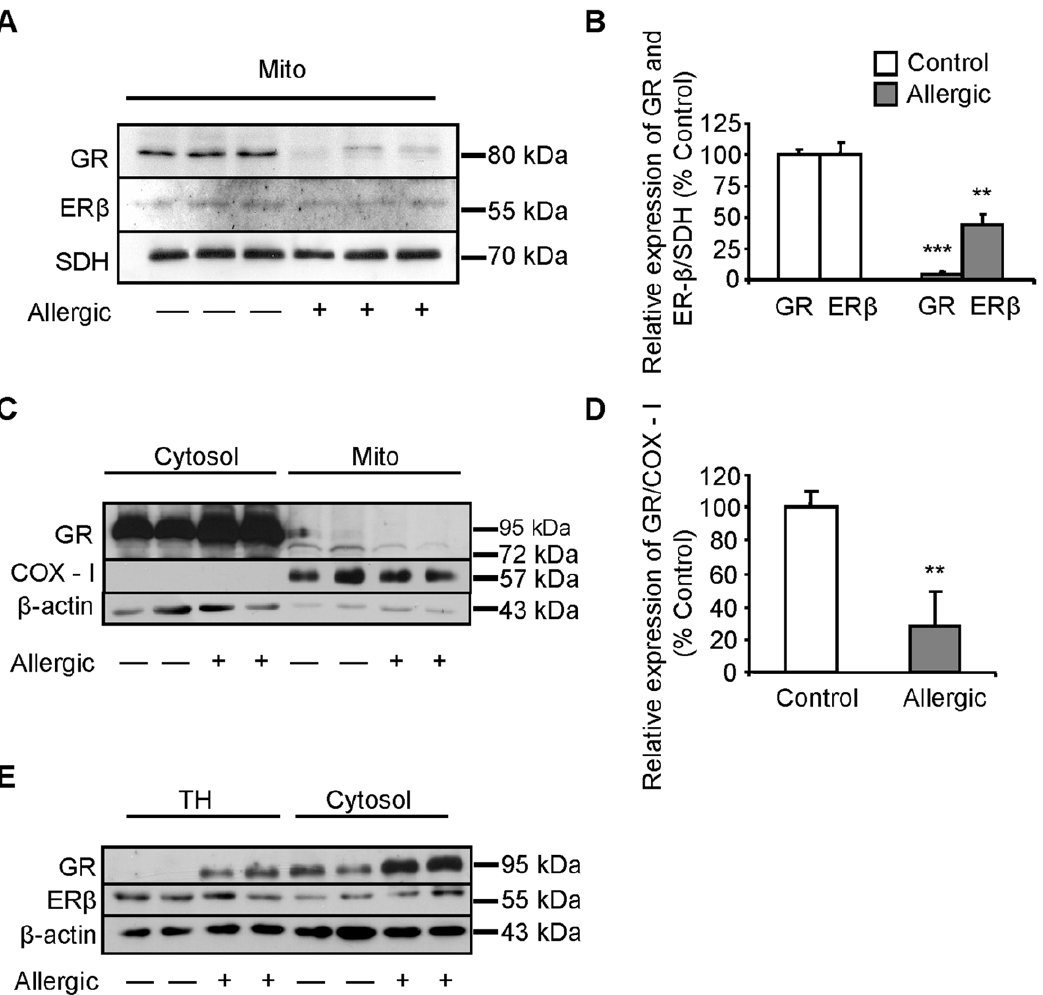
Figure 2. Allergic airway inflammation reduces GR and ER b in highly purified mitochondrial fraction. Highly purified mitochondria were isolated from total lung homogenates from allergic and control mice as described in Methods section. (A) Representative Western blot images showing mtGR and mtER b in isolated mitochondrial fraction. (B) Quantitation of band intensity by densitometry from blots after normalization against the succinate-ubiquinol oxidoreductase subunit of the mitochondrial Complex II OXPHOS enzyme (SDH). (C) Western blot analysis of GR, COX-I, and b -actin protein levels in cytosolic (Cytosol) and mitochondrial (Mito) fractions from control and allergic mice. (D) Quantitation of mtGR band intensity by densitometry after normalization against the expression levels of COX-I protein. (E) Western blot analysis of GR, ER b , and b -actin, in total homogenates (TH) and cytosolic fractions from control and allergic mice. Results are presented as means 6 SEM; relative measurements of GR and ER b were set at 100% for control mice. n=10–12 mice per group; ** p , 0.001; *** p , 0.0001 from